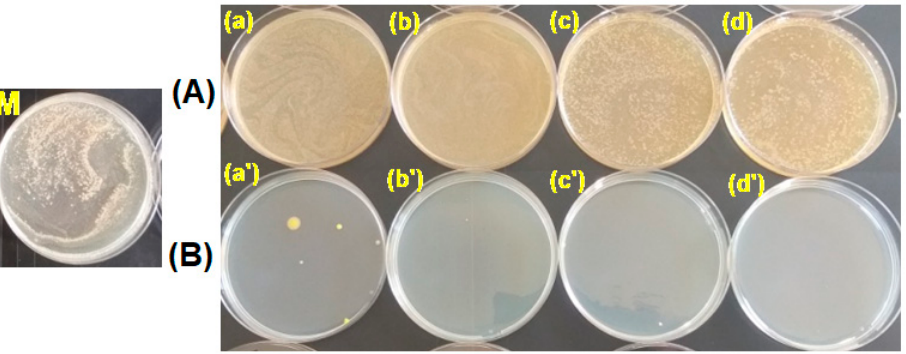
Figure 13. Antimicrobial activity of PSFEtP + polysulfone at different concentrations: C 1 ( a , a’ ), C 2 ( b , b’ ), C 3 ( c , c’ ), C 4 ( d , d’ ) against Escherichia coli for different times, ( A ) T 1 = 3 h and ( B ) T 2 = 24 h, compared to control sample (M).